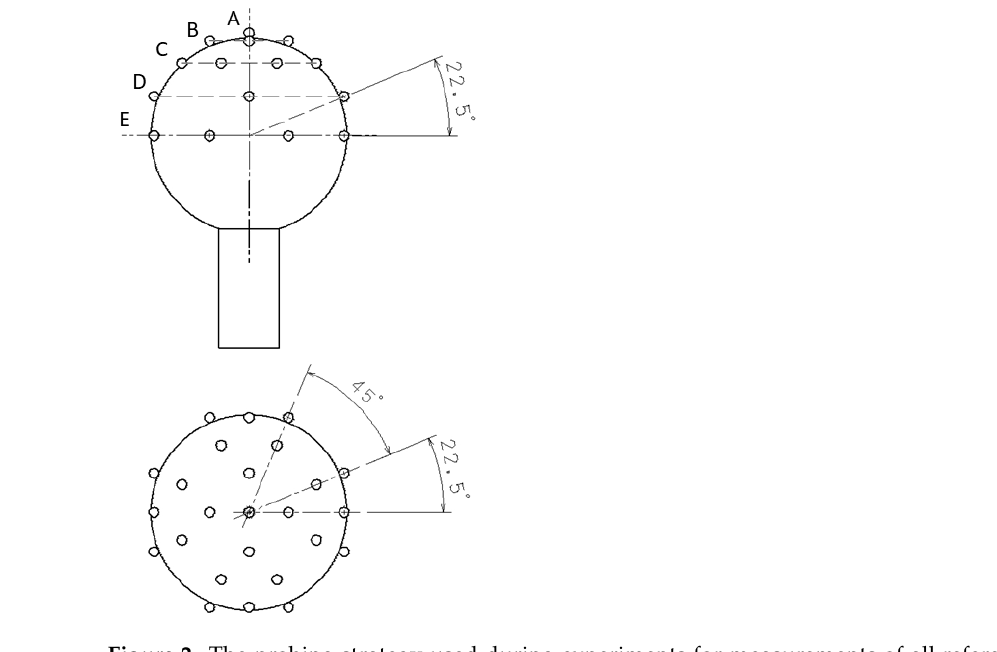
Figure 2. The probing strategy used during experiments for measurements of all reference balls. ( Upper ) sketch presents front view, ( lower ) sketch presents top view.